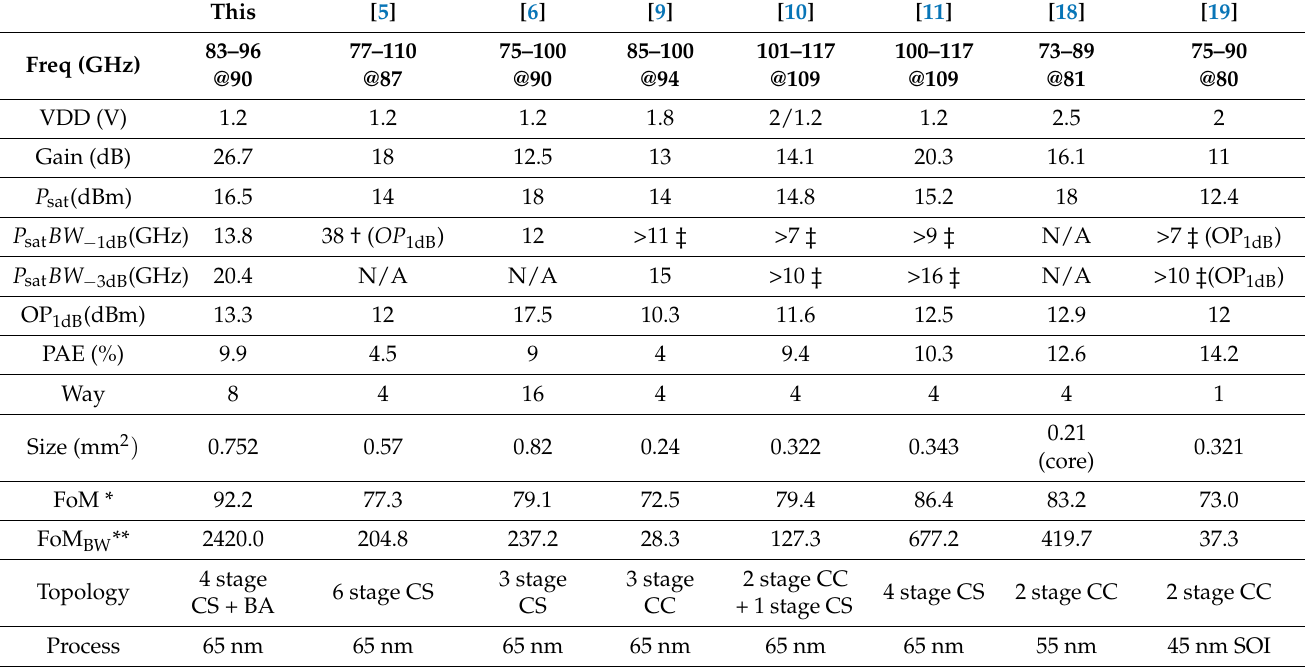
† Simulated result. ‡ Graphically estimated from measurements. * FoM = P sat [dBm] + Gain[dB] + 10log(PAE[%] × f